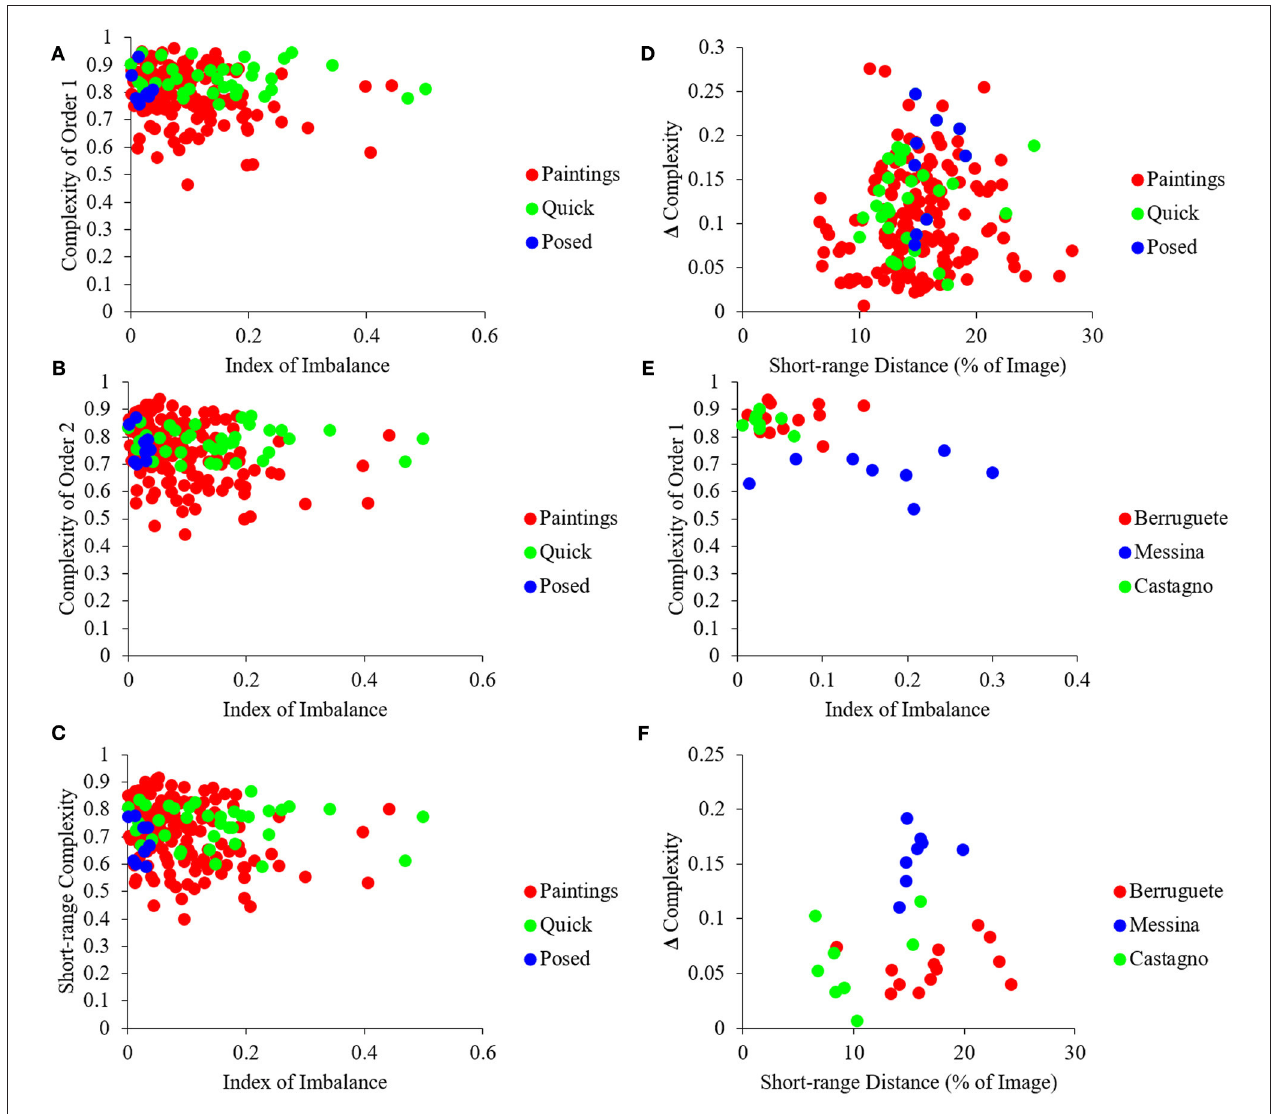
FIGURE 5 | Quantification of different measures of complexity (see Figure 1 for definitions). (A) Same as Figure 4A but for Complexity of Order 1 vs. the Index of Imbalance. (B) Same as (A) but for Median Complexity of Order 2. (C) Same as (A) but for Short-range Complexity. (D) Same as (A) but for 1 Complexity vs. Short-range Distance. (E) Same as (A) but for three example artists, namely, Pedro Berruguete, Antonello da Messina, and Andrea del Castagno. (F) , Same as (D) but for these three artists. Although many paintings have lower complexity in terms of intensities than all photographs (A) , after spatial organization, many paintings become more complex than the photographs (B,C) . As in Figure 4 , artists “reside” in different areas of the possible values, indicating individuality and choice (D,F) . (See text for more